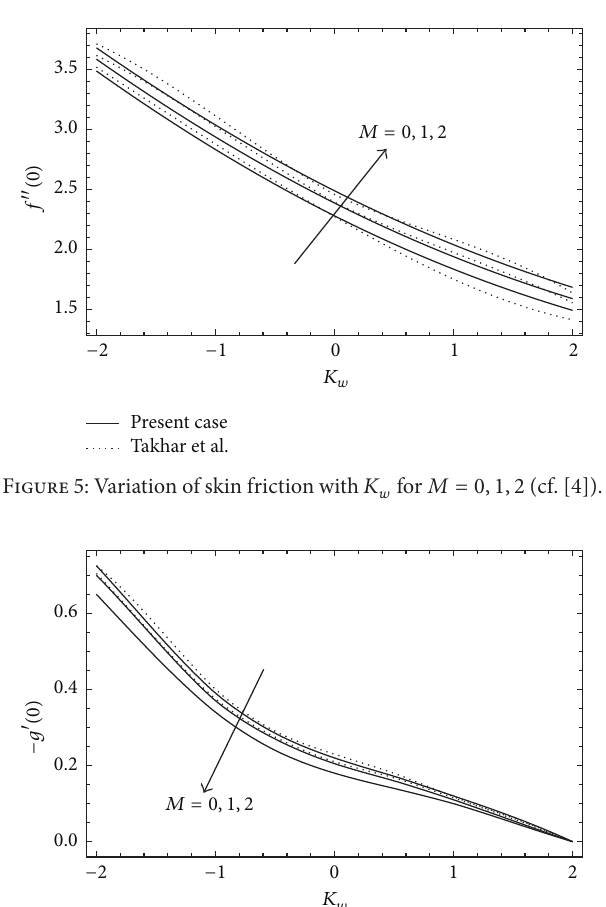
Present case Takhar et al. Figure 6: Variation of heat transfer and mass diffusion parameters with 𝐾 𝑤 for 𝑀 = 0, 1, 2 and Pr = Sc = 0.7, 𝑁 = 0 (cf. with [4]).